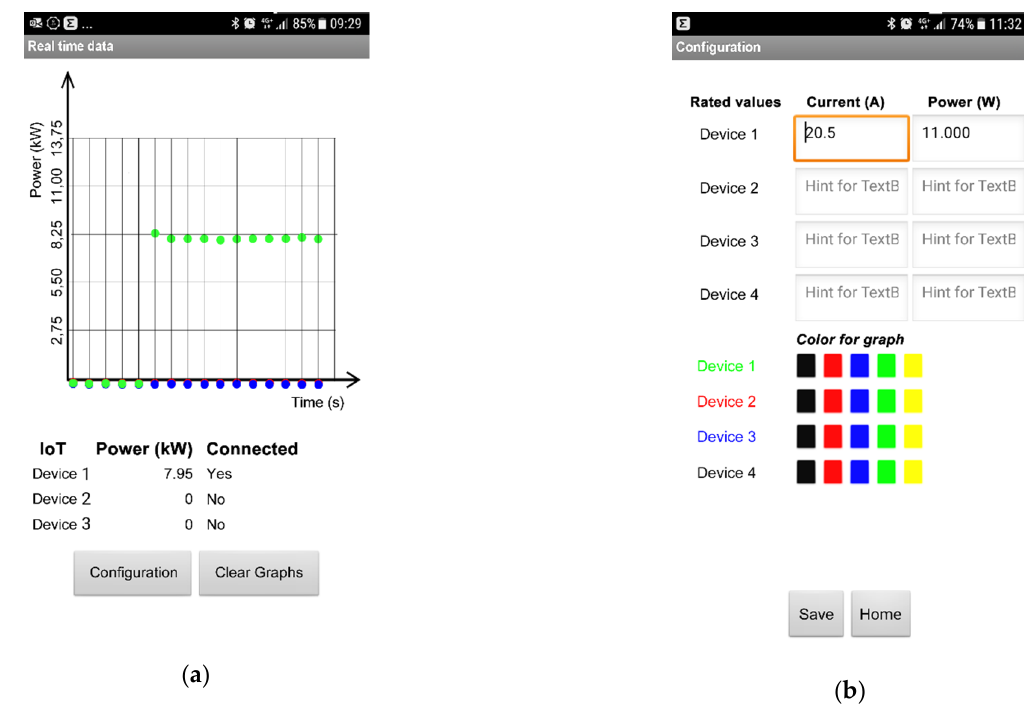
Figure 9. The screenshot of the client. ( a ) The main panel with mechanical power vs. time; ( b ) The configuration panel to upload the rated values for each device.